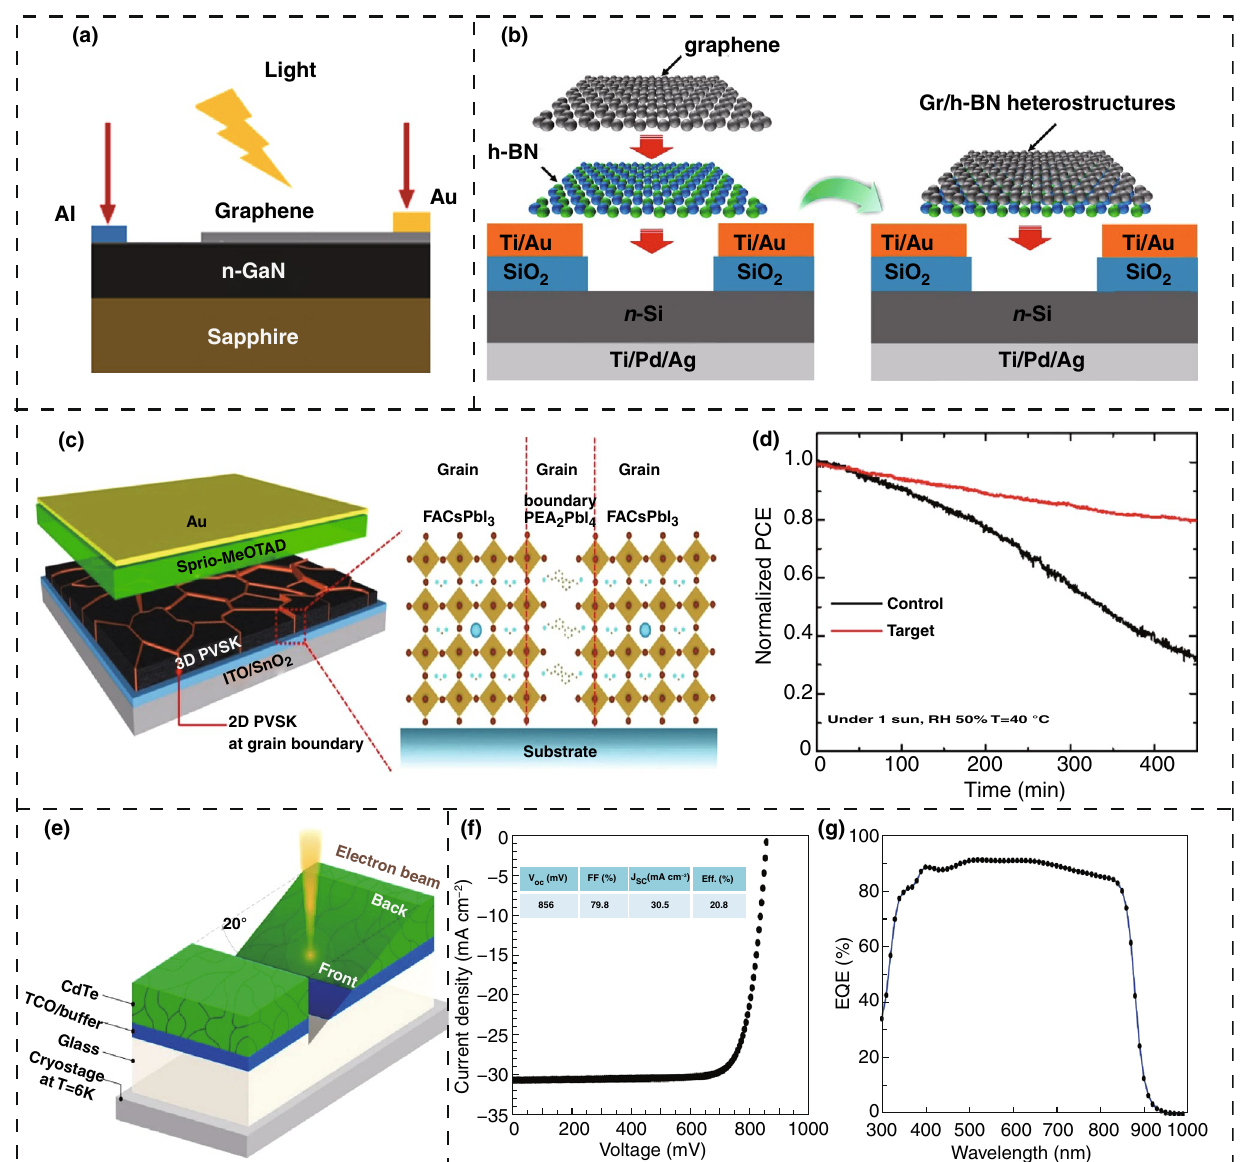
Fig. 2 Mechanism of solar energy scavenging through solar cells. a Diagram of nanodevice based on heterojunction of Graphene/n-GaN. b Schematic of solar cell fabricated through one- and two-step method. c Two-dimensional perovskite at grain boundary of device d Tracking of highest powerpoint of the device with no encapsulation under normal condition. e Sample excitation with electron beam. f Current density–volt- age curve for the device with As doping without any Cu addition. g Relative EQE values with wavelengths. Figures reprinted with permission from: a Ref. [62], © 2017 American Institute of Physics; b Ref. [63], © 2016 Elsevier; c , d Ref. [66], © 2018 Nature; e , f , g Ref. [64], © 2019